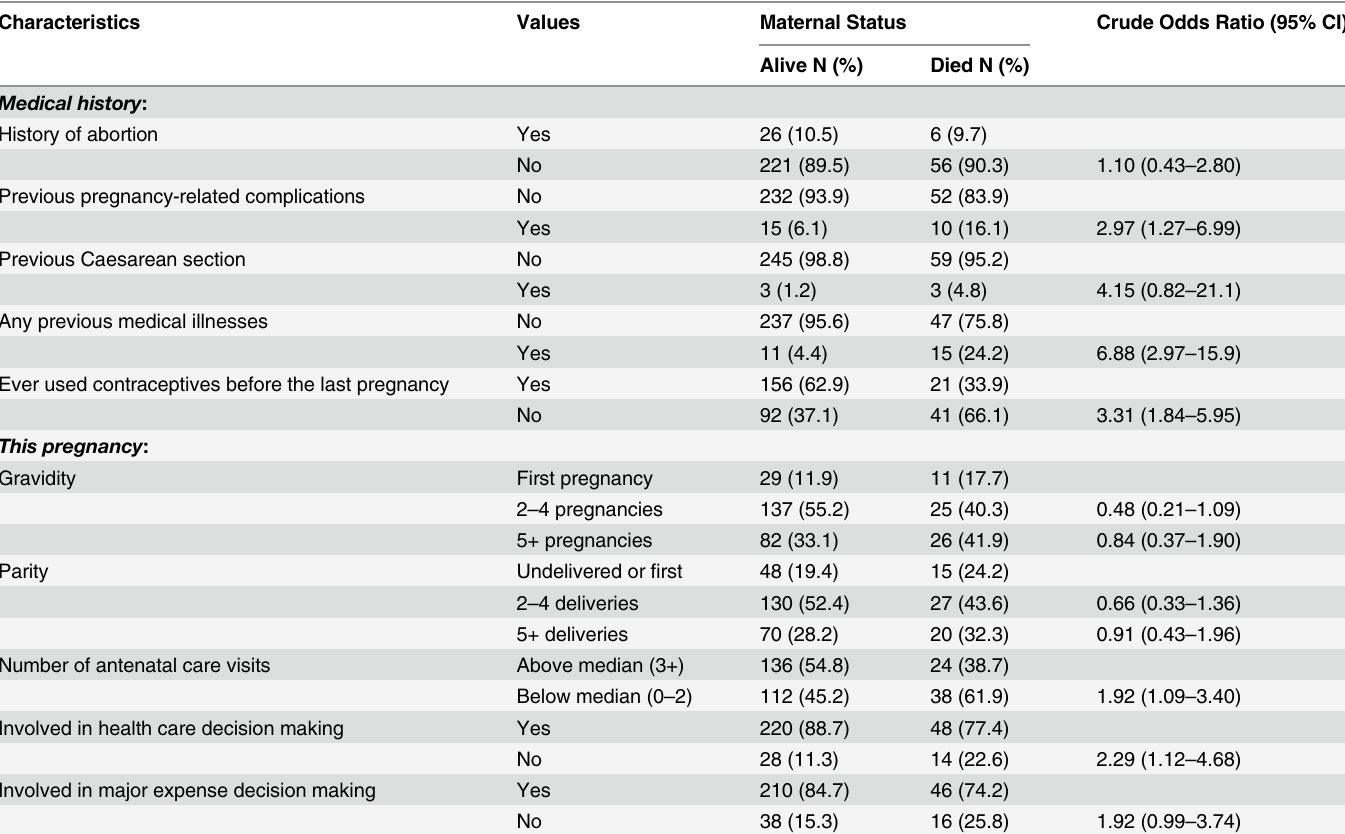
Table 3. Health related characteristics and women ’ s decision making power for 62 rural Tigrean women who died of maternal causes and 248 con- trols (who had given birth in the study period May 2012 to August 2013 and lived in the same communities as the maternal